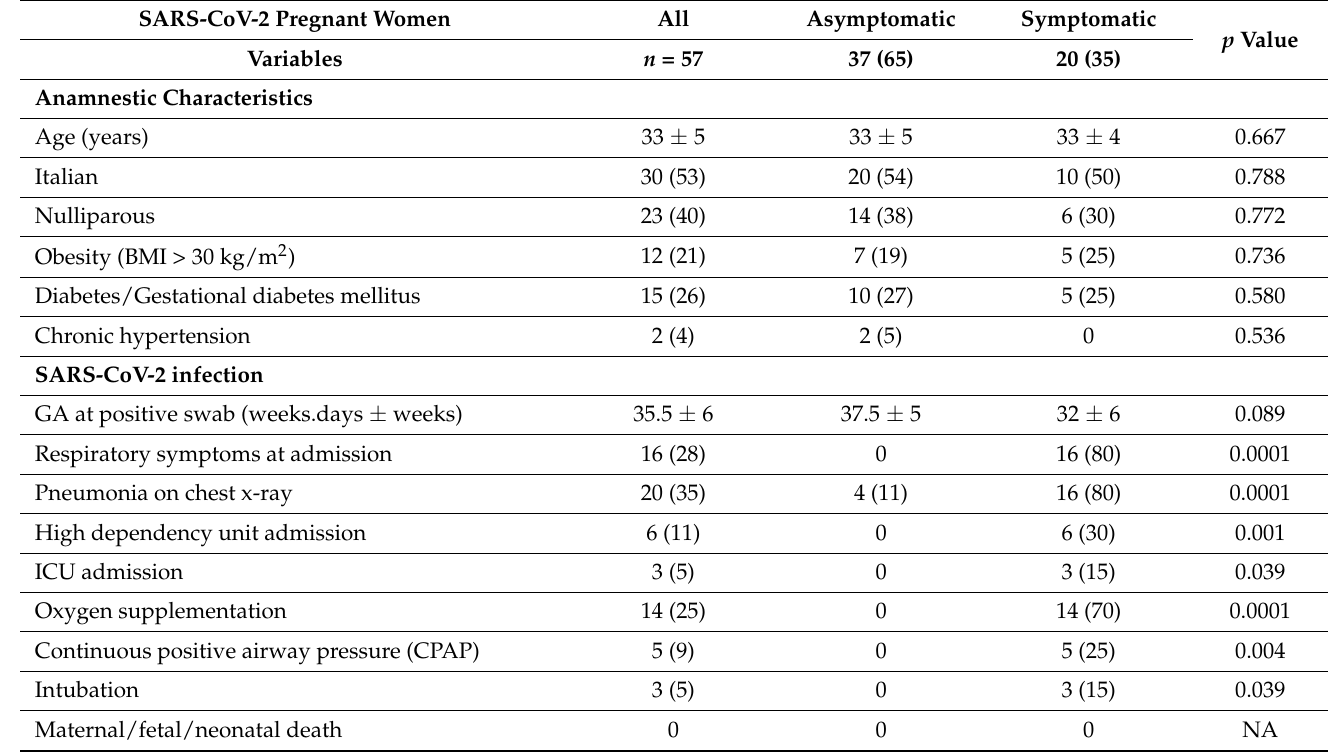
Table 1. Population characteristics comparing positive SARS-CoV-2 pregnant women with signs and symptoms of COVID- 19 at admission to asymptomatic women. SARS-CoV-2 Pregnant